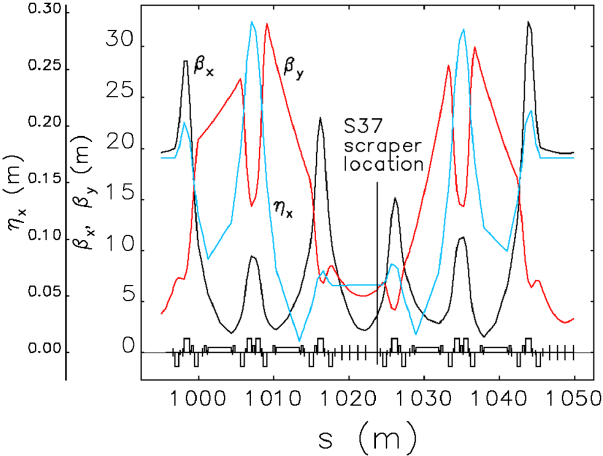
FIG. 14. The reduced-horizontal-beam-size lattice functions in S37 and S38. The collimators were positioned at s ¼ 1023 . 78 m. Horizontal and vertical tunes were 36.169 and